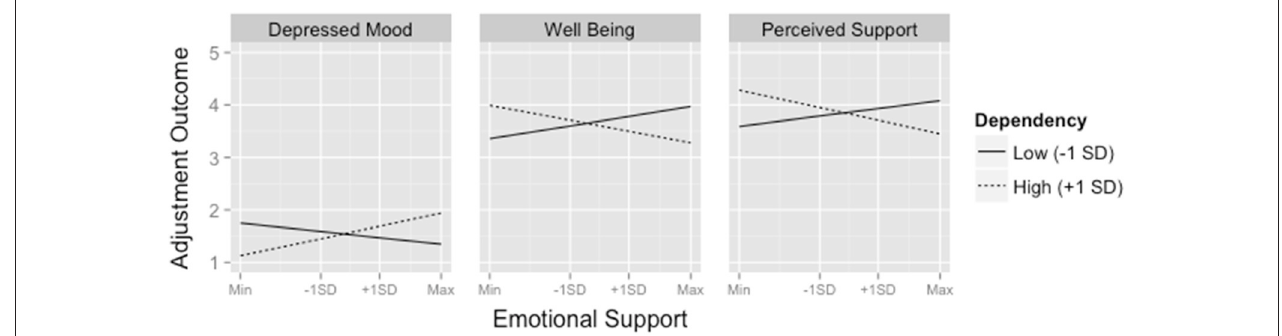
FIGURE 1 | Predicted values of depressed mood, well-being, and perceived support as a function of emotional support at 1 SD above and below the mean of dependency. Adjustment outcomes were measured on a 1–5 Likert scale. To aid in interpretation of the group-mean centered Emotional Support variable, tick-marks on the x-axis are provided for ± 1 standard deviation away from individuals’ means as well as the minimum and maximum values in the dataset.